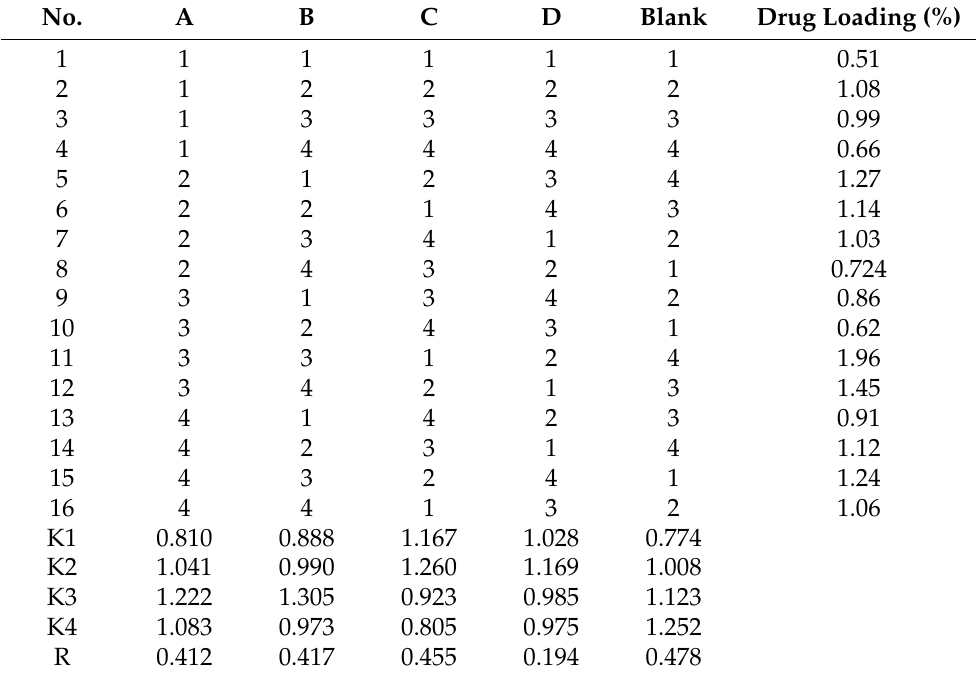
Table 2. L 16 (4 5 ) orthogonal design table and results ( n = 3).